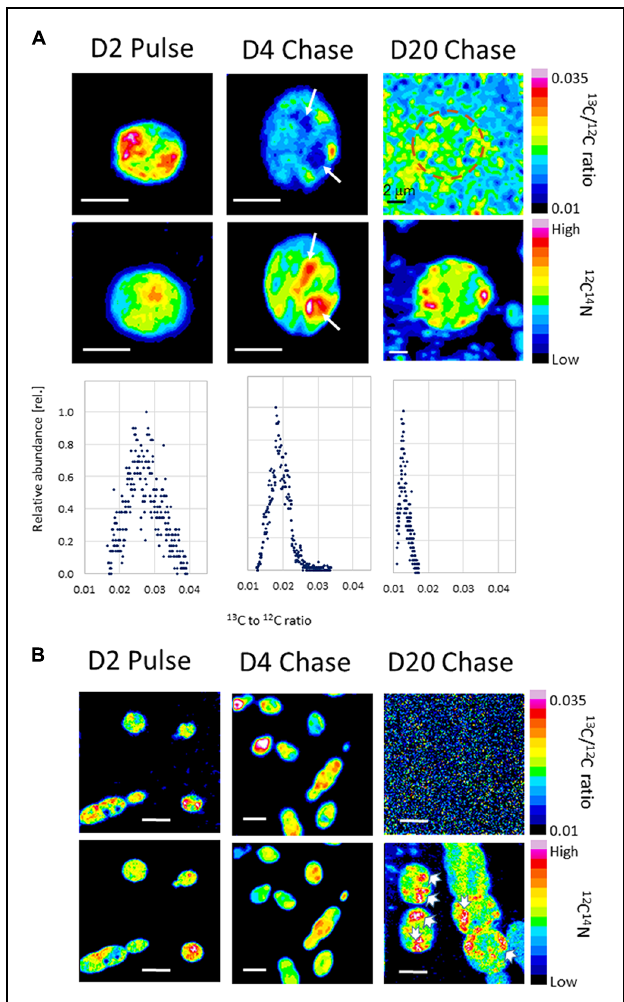
FIGURE 6 | Secondary ion images of (A) vegetative cells (D2 Pulse and D4 Chase) and of an akinete (D20 Chase) of A. ovalisporum and (B) corresponding filaments. Images are based on NanoSIMS analysis. 13 C bicarbonate was provided to akinete-induced cultures for the first 2 days and chased with 12 C bicarbonate for additional 18 days during which akinete differentiation occurred. Images in (A) represent transverse section of vegetative cells or an akinete. Note size differences between vegetative cells and akinetes. (A) The upper row images represent 13 C to 12 C ratio. Note the white arrows in D4 Chase image indicating new synthesis of presumable cyanophycin. The D20 Chase image indicates reduced 13 C signal ( 13 C to 12 C ratio near the background level) which masks the location of an akinete (presented by a dotted circle which was allocated based on the overlay with the corresponding 12 C 14 N ion image). The lower row images show the localization of N-enriched compounds based on the 12 C 14 N ion. Bar scales = 2 μ m. Color scales for images is provided. The graphs at the lower row show the relative distribution of 13 C to 12 C ratio of more than 2000 pixels composed each cellular image, indicating 13 C dilution during the chase period. (B) The upper row images represent 13 C to 12 C ratio in several filaments. Note the D20 Chase image with substantially reduced 13 C signal ( 13 C-to- 12 C ratio near the background level) which masks the location of the filaments. The lower row images show the localization of N-enriched compounds in the same filaments based on the 12 C 14 N ion. Note the localization of high 12 C 14 N ion signal in D20 Chase image, presumably presented cyanophycin (indicated by white arrows) in free akinetes and in attached akinetes. Bar scales = 4 μ m. Color scales for images is